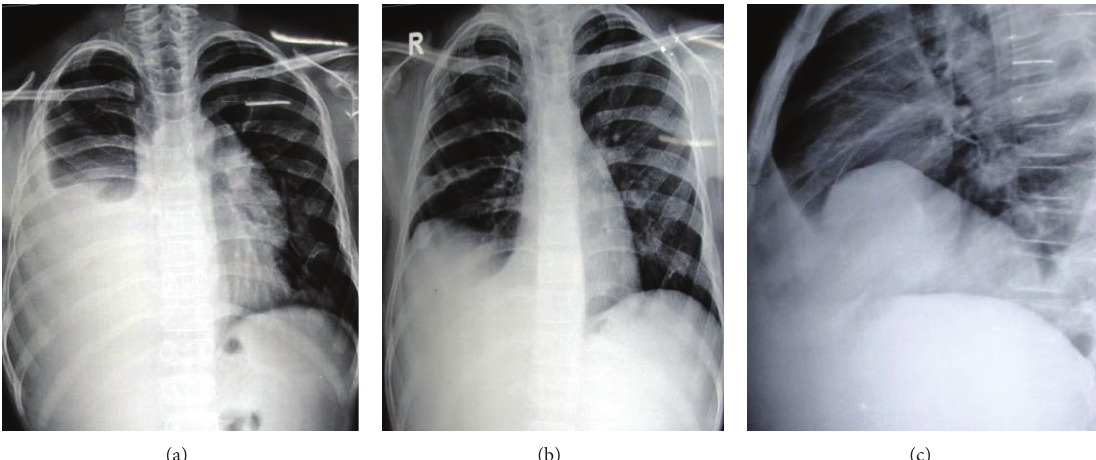
Figure 1: (a) Chest X-ray posteroanterior view showing right moderate pleural effusion with left mediastinal effusion (arrow). (b) Chest X- ray PA view postaspiration film showing residual right effusion and multiple osteolytic lesions in ribs bilaterally. (c) Chest X-ray right lateral view showing well defined opacity in lower part of